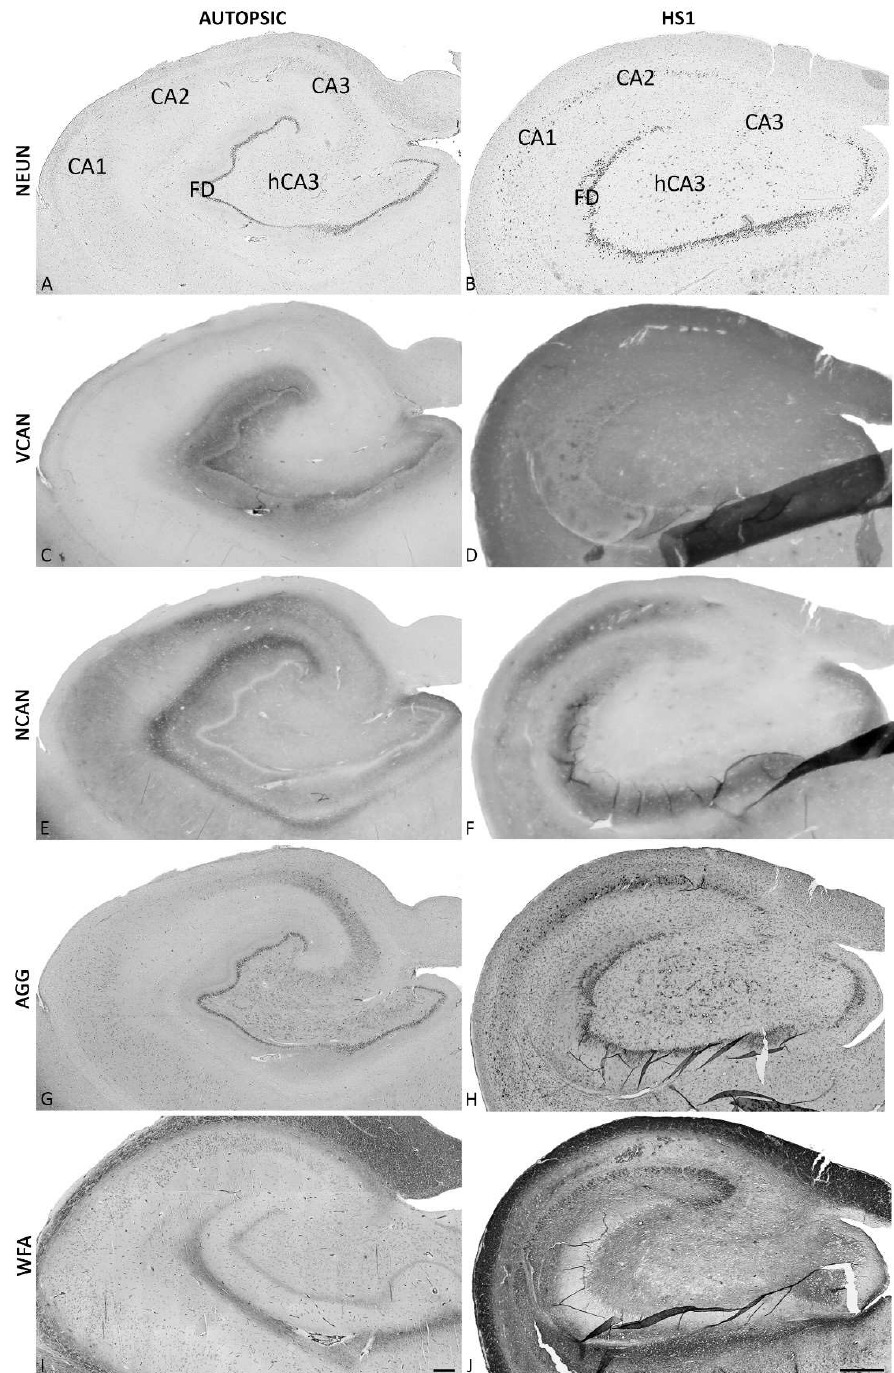
Figure 3. Coronal sections of human hippocampi: autopsic (left column of images, ( A , C , E , G , I )) and sclerotic (HS1, right column of images, ( B , D , F , H , J )) stained for NeuN ( A , B ), versican (VCAN; ( C , D )), neurocan (NCAN; ( E , F )), aggrecan (AGG; ( G , H )) and with Wisteria Floribunda agglutinin ( I , J ). The VCAN exhibited the most prominent change of expression ( C , D ). While the diffuse VCAN expression was detected only in the FD of the autopsic hippocampi, a diffuse VCAN expression is prominent in all hippocampal fields of HS1 ( D ). On the contrary, the differential expression of NCAN among areas and layers of both autopsic hippocampi and HS1 ( E , F ) is slightly changed due to changed histoarchitectonics of the sclerotic hippocampi: a decreased NCAN expression is noticeable in CA3 areas while preserved in CA2 pyl, and robust in CA1′s mol ( F ). The condensed forms